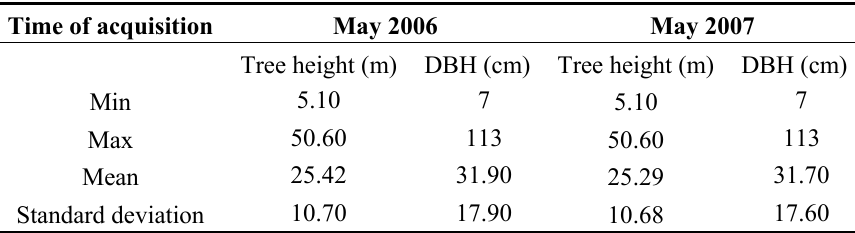
Table 5. Statistical summary of field tree variables in Test Site